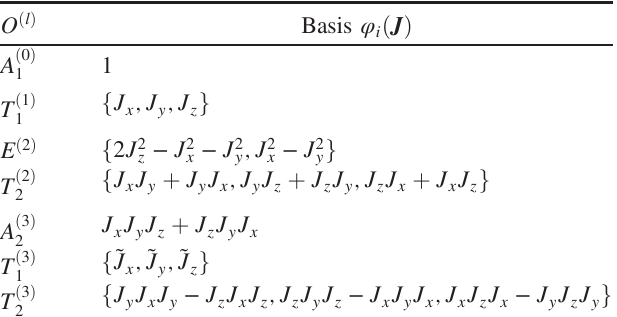
TABLE I. Classification of the spin basis for the 4 × 4 matrices according to O -point-group symmetry. The columns correspond to an irreducible representation of O -point-group symmetry, with indices for the amplitude l of coupled angular momentum for two 3 = 2 spins, and the basis matrix.